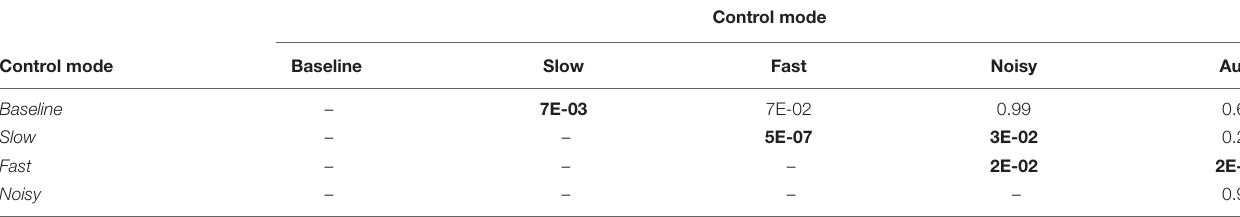
TABLE 2B | Post hoc comparisons ( p -value) between control modes for difference (shift) in normalized agency, (cid:49) agency = implicit –